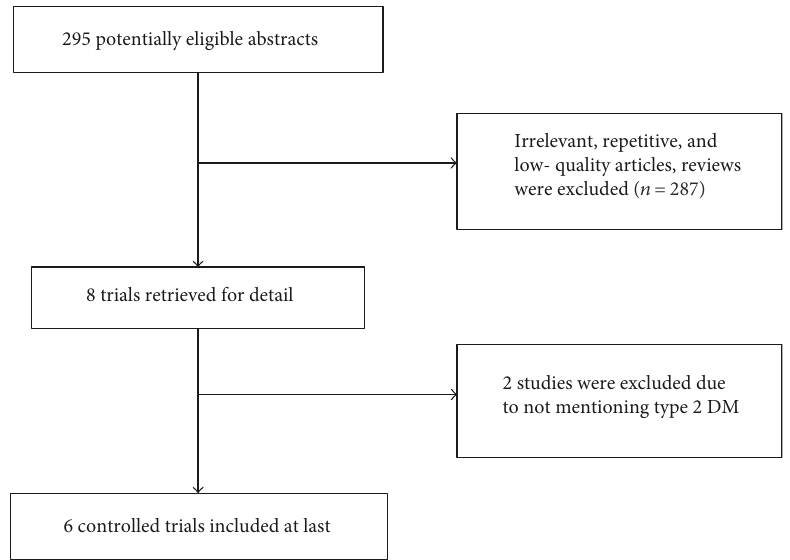
Figure 1: Flow chart of study